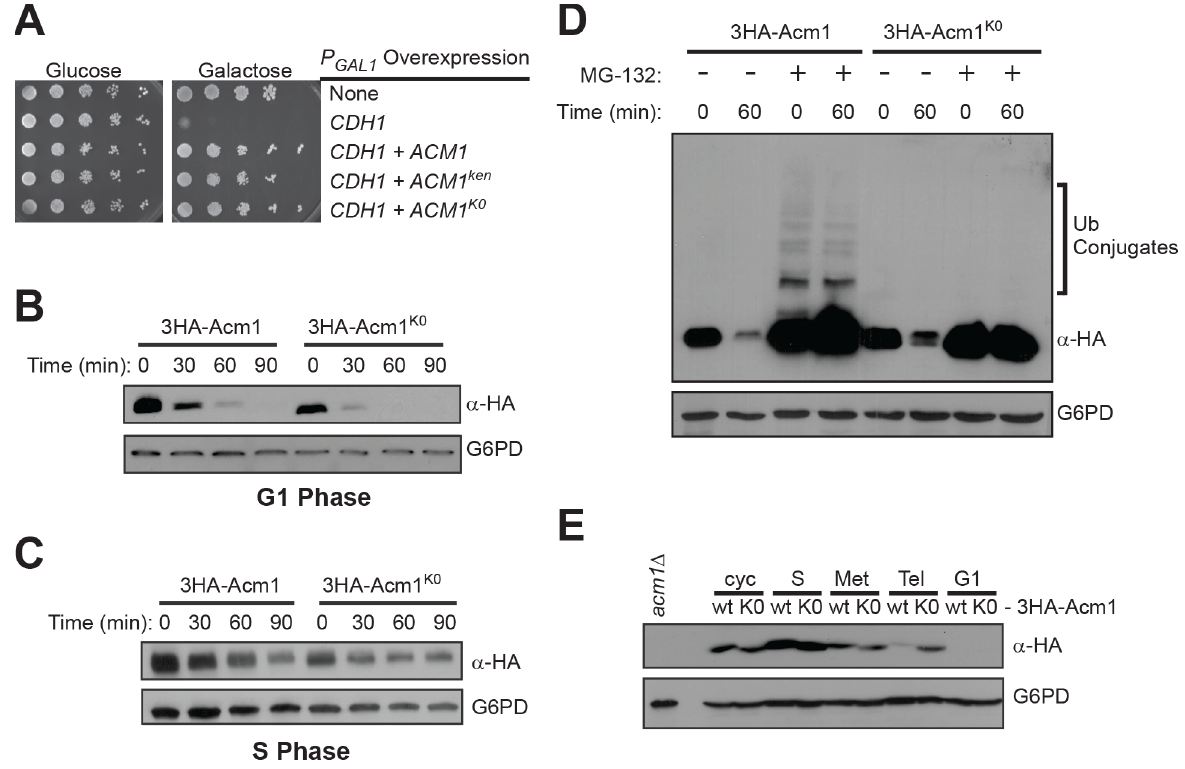
Figure 5. Acm1 proteolysis does not require ubiquitin acceptor sites on Acm1. A) YKA247 cells carrying P GAL1 expression plasmids for 3FLAG-Cdh1, 3HA-Acm1, HA-Acm1-ken, and 3HA-Acm1 K0 in the indicated combinations were grown until mid-exponential phase. 10-fold serial dilutions were spotted on selective media containing either glucose or galactose. Plates were incubated at 30 u C for 2–3 days. B) and C) YKA247 cells carrying P GAL1 expression plasmids for 3HA-Acm1 (pHLP117) or lysine-less 3HA-Acm1 K0 mutant (pHLP330) were grown in YP-raffinose to early exponential phase. Cells were arrested at G1 (panel B) or S phase (panel C). Stability of 3HA-Acm1 and 3HA-Acm1 K0 was monitored over the indicated time period by immunoblotting with anti-HA antibody. G6PDH is a loading control. D) Same as panels B and C, except pdr5 D cells were used and stability was monitored in the presence and absence of MG-132 as indicated. Longer immunoblot exposures were obtained for detection of ubiquitin (Ub) conjugates. E) cdc15-2 cells carrying centromeric plasmids expressing either wild-type 3HA-Acm1 or 3HA-Acm1 K0 from the natural ACM1 promoter were arrested at the indicated cell cycle stages as described in Materials and Methods. The level of each protein was then compared by anti-HA immunoblotting with G6PD as a loading control.